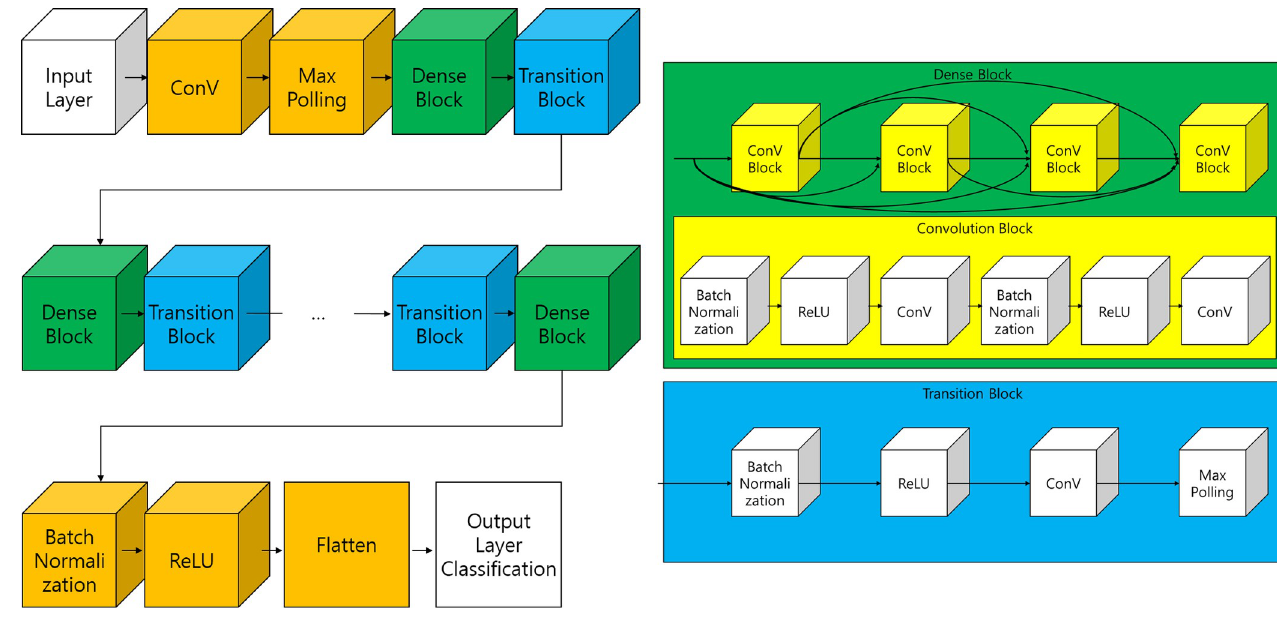
Fig 2. Architecture of